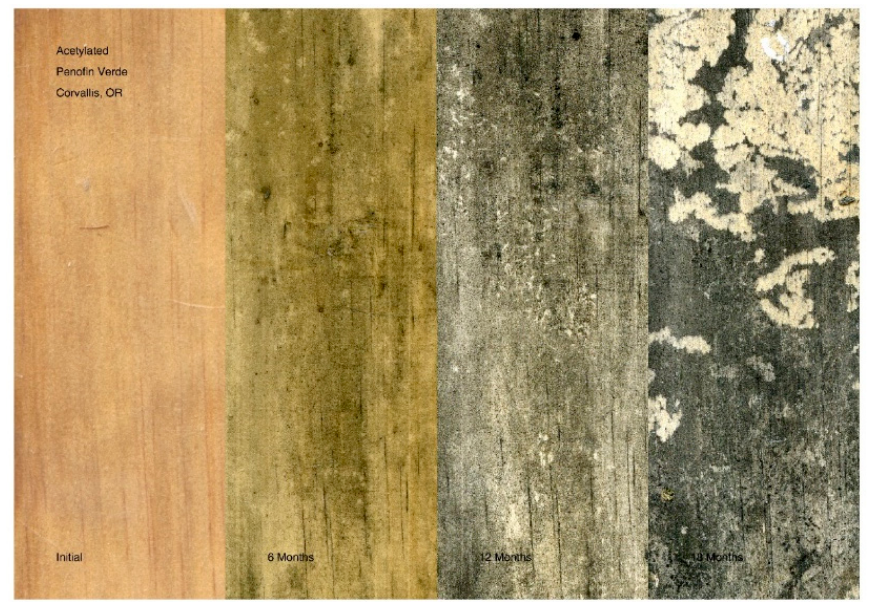
Figure 9. Examples of the same sample of acetylated wood treated with Penofin Verde and exposed for 0, 6, 12, and 18 months near Corvallis, OR (left to right).